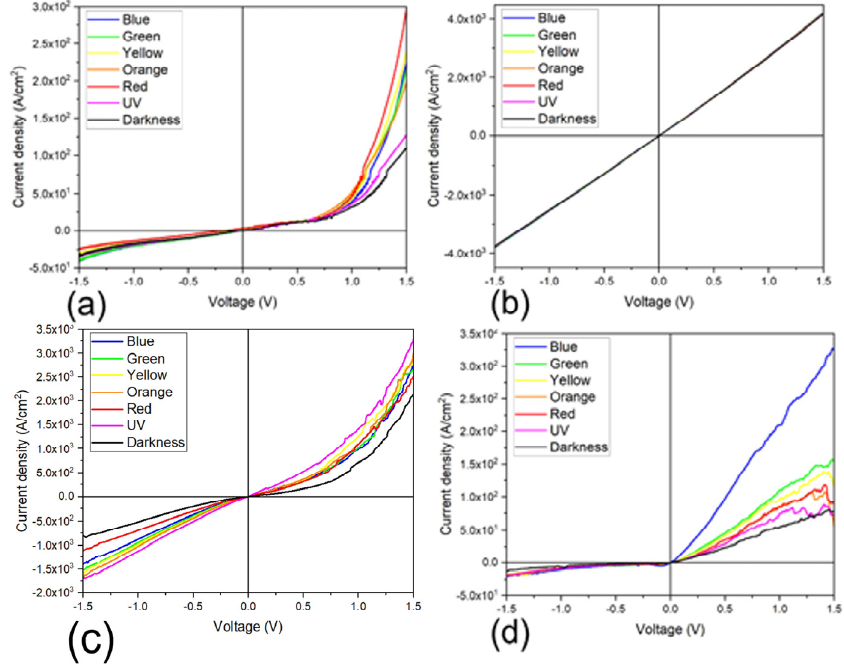
Figure 12. Different light color J–V characteristic curve plot of ( a ) TiCl 2 Pc and ( b ) TiOPc films and ( c , d ) devices, respectively.